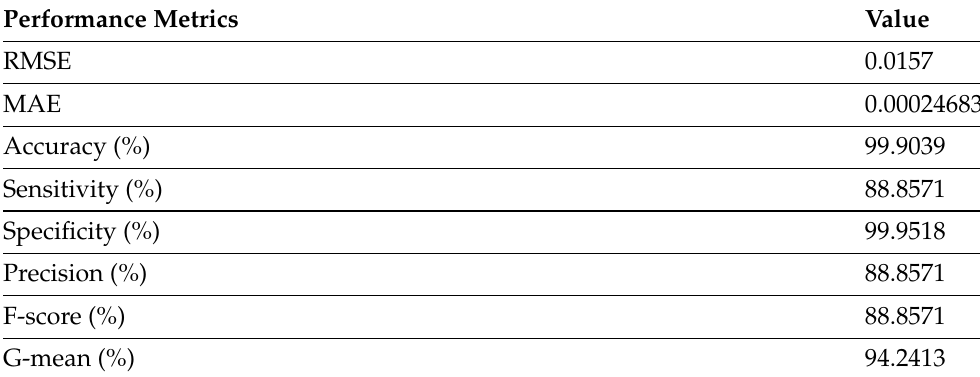
Table 6. The trained model evaluation